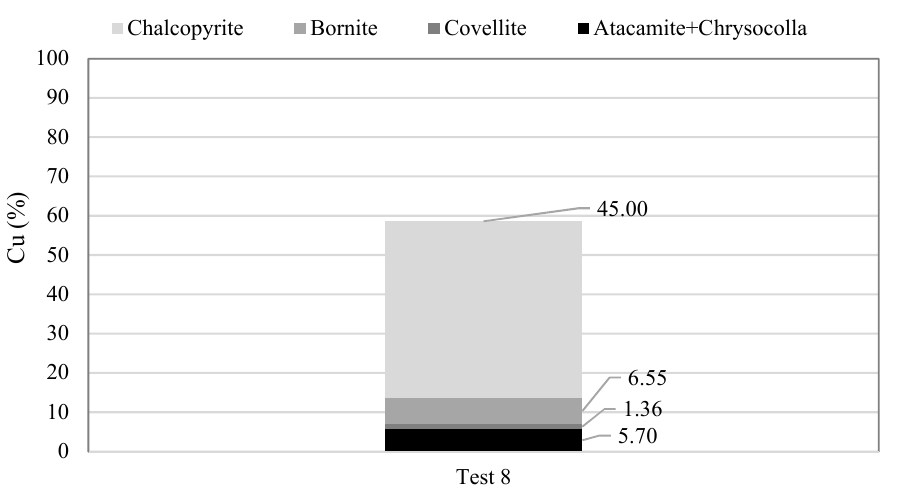
Figure 2. Copper extraction by sequential leaching mineralogical copper species obtained in test 8.